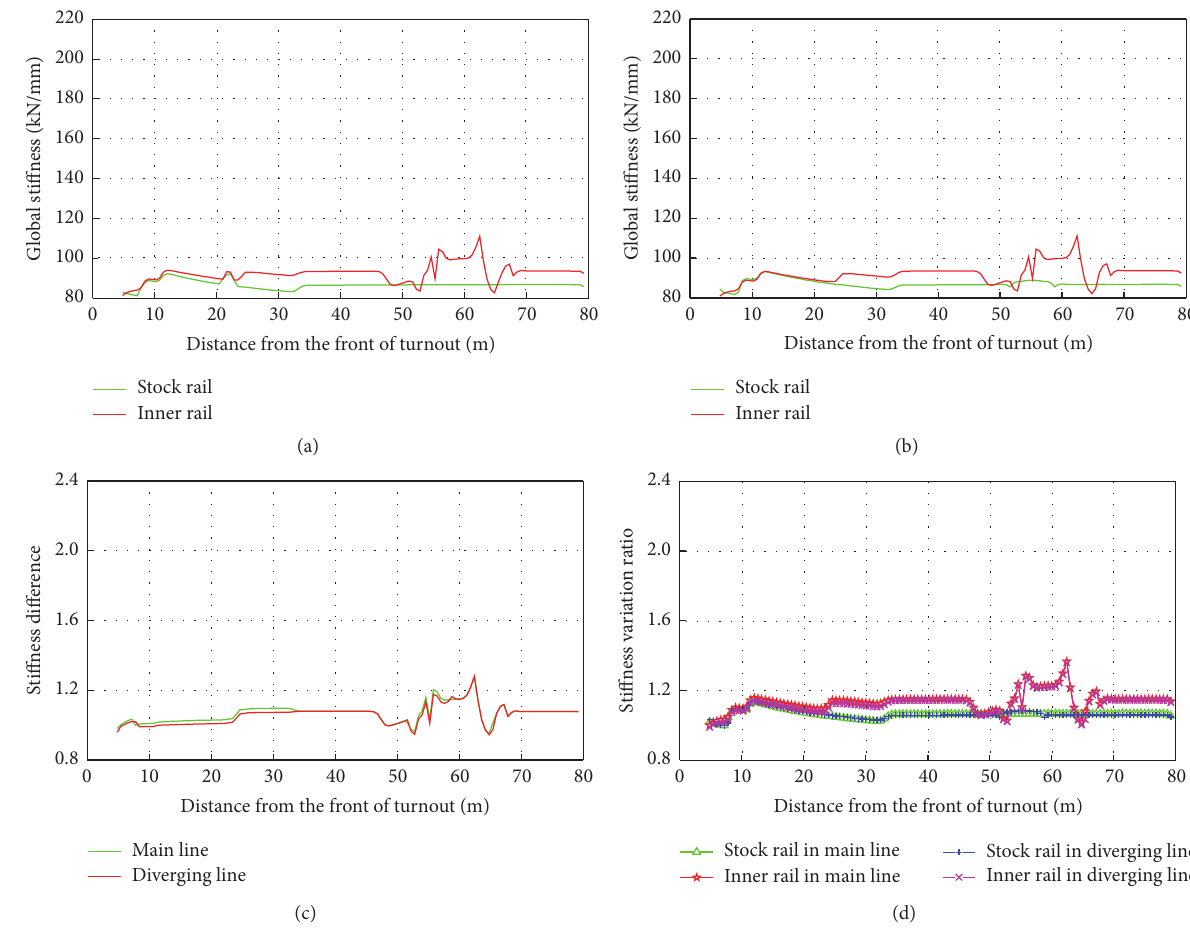
Figure 5: Distribution of stiffness in high-speed railway turnout after optimisation ((a) the main line; (b) the diverging line; (c) the stiffness difference of turnout rails; (d) the stiffness variation